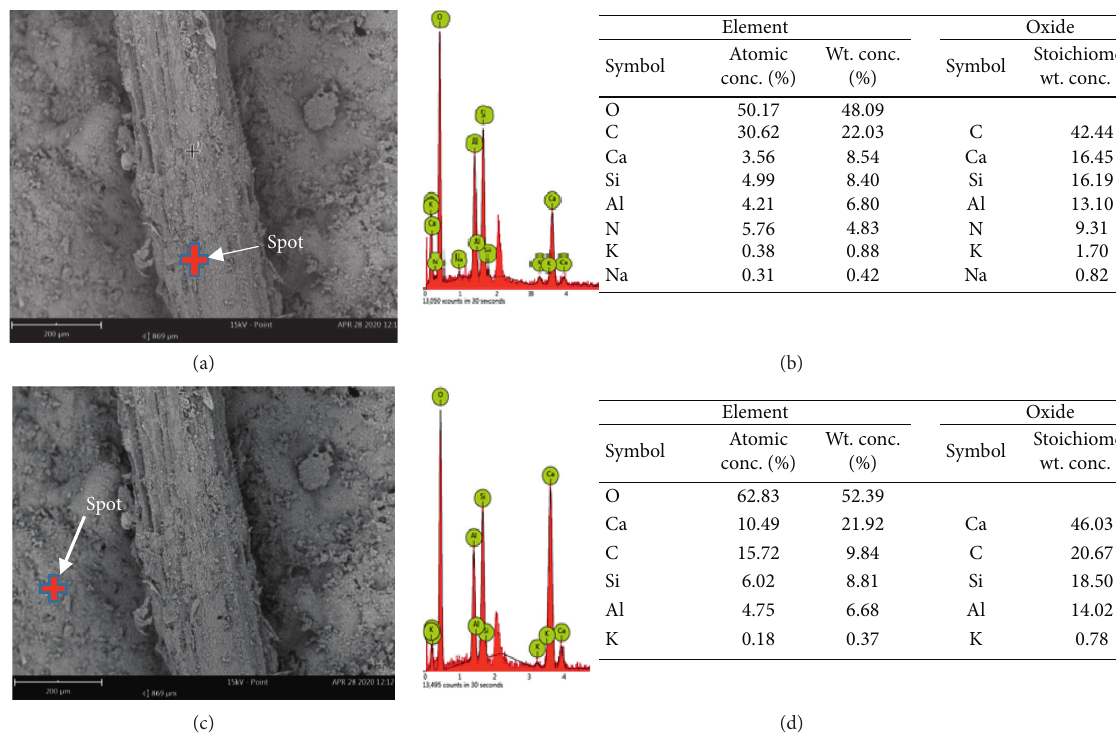
Figure 9: EDS analysis on specimen. (a) Selected spot image on fibre. (b) Chemical composition of matrix expressed as percentage of the elements and oxides for spot on fibre. (c) Selected spot image on mortar. (d) Chemical composition of matrix expressed as percentage of the elements and oxides for spot on mortar.